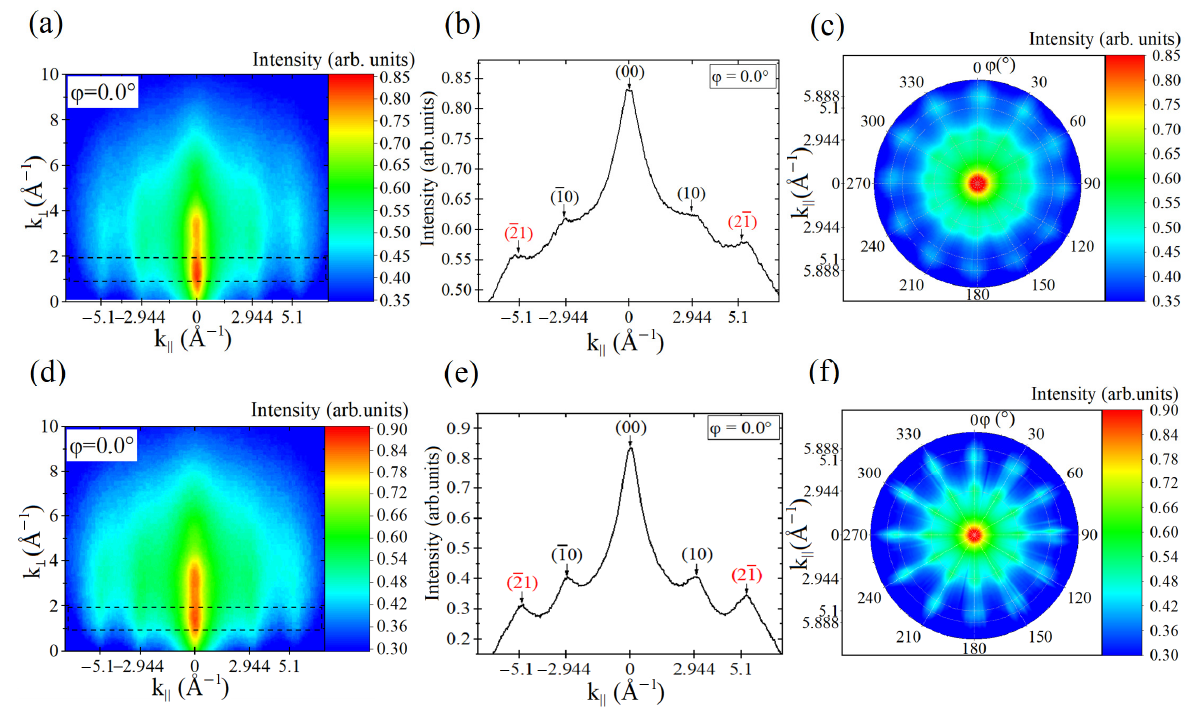
Figure 4. Images of RHEED patterns obtained of FLG ( a ) and MLG ( d ) at azimuthal angles φ = 0° ( a , d ). Intensity profiles for azimuthal angles φ = 0° ( b , e ) for FLG ( b ) and MLG ( e ), respectively. ( c , f ) The RHEED reciprocal space structures for the FLG ( c ) and MLG ( f ) samples.